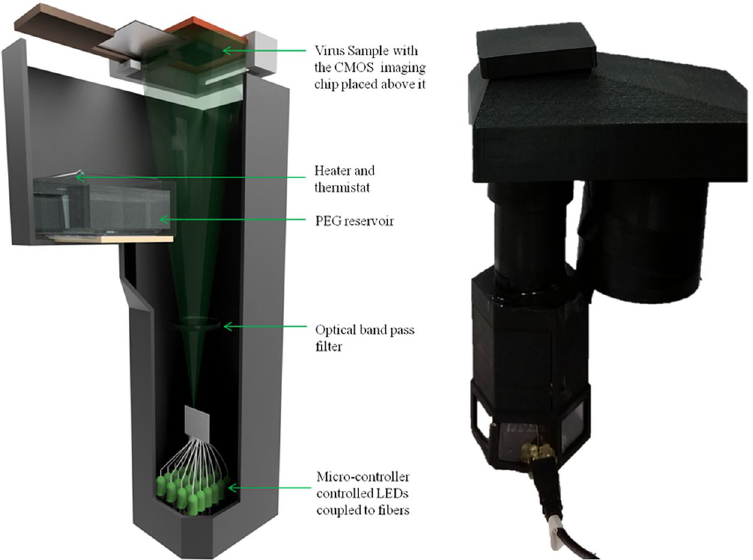
Figure 1. The schematic diagram of the hardware of the portable lensfree microscope is shown on the left. The photograph of the same microscope is shown on the right. This device is about 25 cm in height and weighs less than 500 grams 29 .